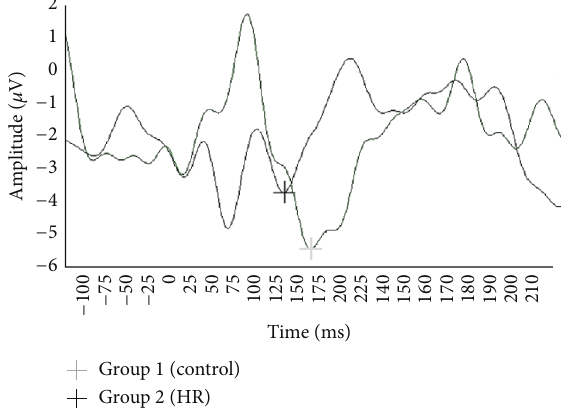
Figure 1: Group amplitude averages for Cz electrode